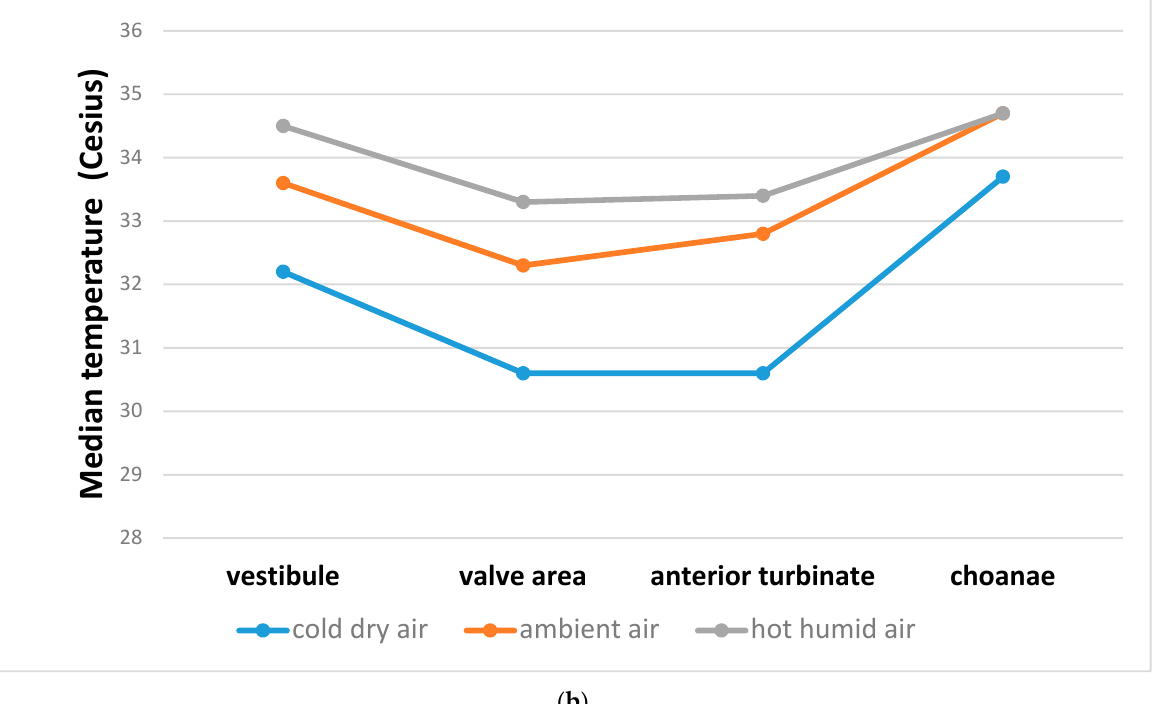
Figure 3. From Liener et al. 2020 [19]. Median mucosal temperatures (Celsius degrees) of four different anatomical nasal districts (vestibule, valve area, anterior turbinate, choanae) at end of inspiration ( a ) and expiration ( b ), after exposures to three different combinations of air temperature and relative humidity (RH), during three consecutive days. Continuous measurements made during a 2 min interval in which subjects inhaled ambient air (24 C; 35% RH) —Day 1 : 10 min exposure to cold dry air (12 C; 13% RH); Day 2 : 10 min exposure to ambient air (24 C; 35% RH); Day 3 : 10 min exposure to hot humid air (40 C; 80% RH).